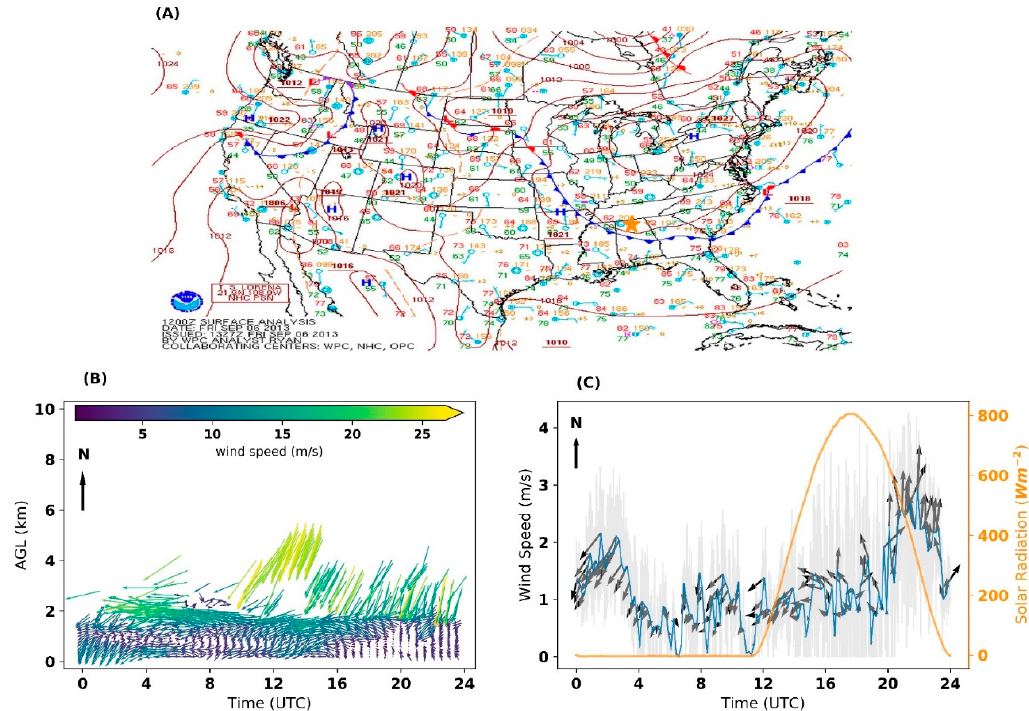
Figure 3. Weather chart and micro-meteorological measurements on 6 September 2013 in Huntsville, AL. ( A ) Weather chart at 1200 z on 6 September 2013 from NOAA (National Climatic Data Center) (http://nomads.ncdc.noaa.gov/ncep/NCEP). The star symbol shows the location of Huntsville, Alabama, USA. ( B ) Wind profiles measured by collocated 915 MHz wind profiler. ( C ) Solar radiation and surface wind measured by the collocated weather